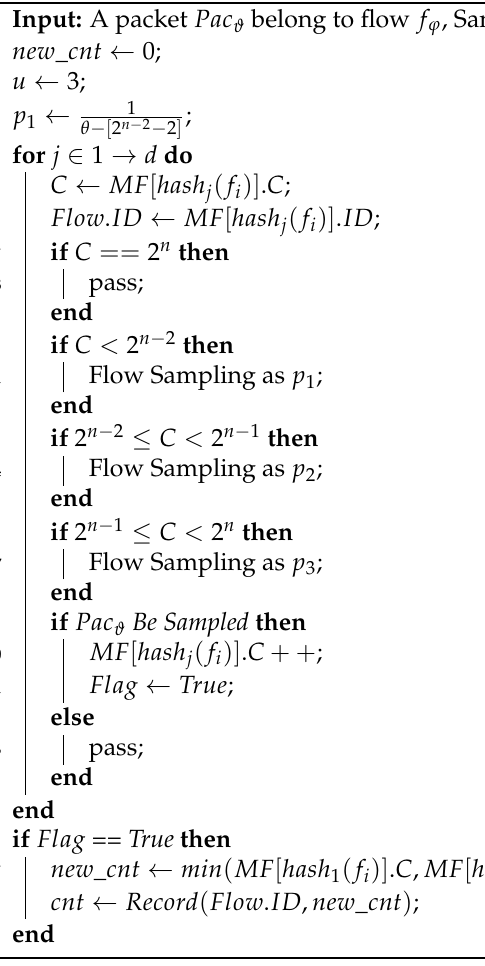
Algorithm 2: Top- k measurement algorithm based on